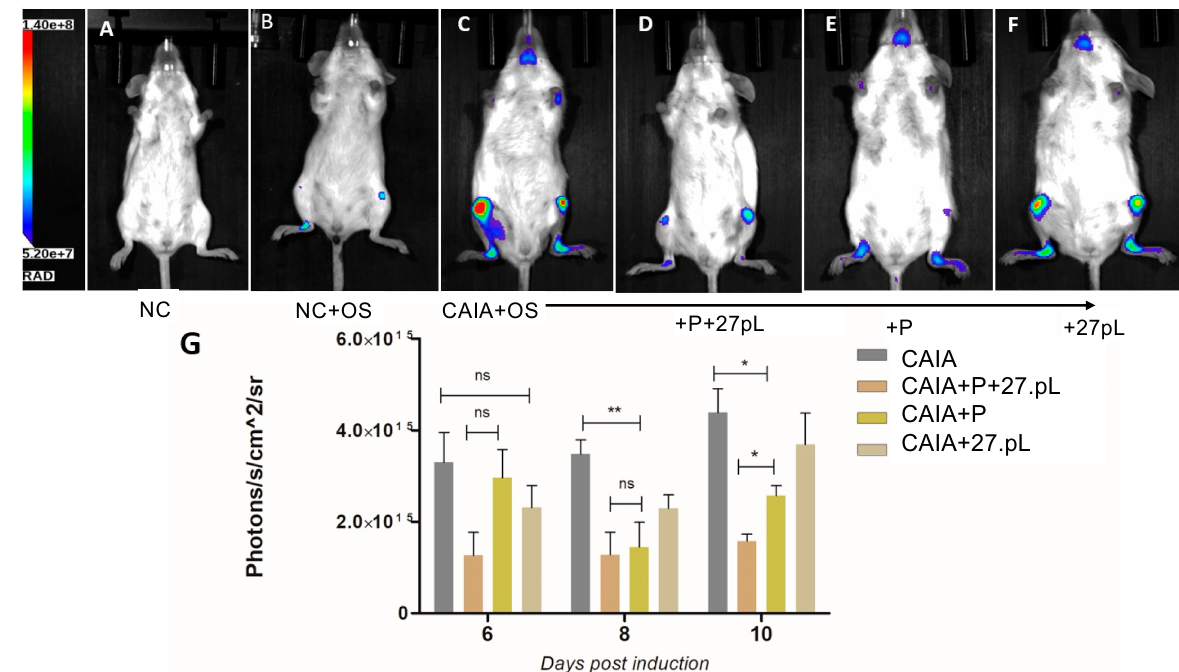
Figure 6. Quantification of bone damage or repair by Osteosense probe fluorescence bioimaging. ( A ) No CAIA (NC) control showing an absence of Osteosense fluorescence. ( B ) NC with an injection of Osteosense showing the basal fluorescence from probe. ( C ) CAIA animals showed extensive damage or changes in bone in the ankle and knee joints, indicating the onset of RA. ( D ) Treatment of CAIA animals with P + 27pL showed significant reduction of bone damage. ( E ) Treatment of CAIA with P showed a reduction in bone damage. ( F ) Treatment of CAIA with 27pL showed no reduction of damage and bone repair. ( G ) Quantification of Osteosense fluorescence on day 6, 8, and 10 post-induction. Treatment with P significantly reduced the bone damage on day 8, and 27pL expression improved its effect on day 10 post-induction. Background (correction) values from the NC + OS group were subtracted in these analyses. Results represent mean ± SEM. A one-way analysis of variance (ANOVA) followed by Tukey’s multiple comparison t-test was used to calculate the statistical difference. The Mann–Whitney non-parametric test was used to calculate the statistical difference between P and P + 27pL (* p ≤ 0.05; ** p ≤ 0.01), with ns, not significant.